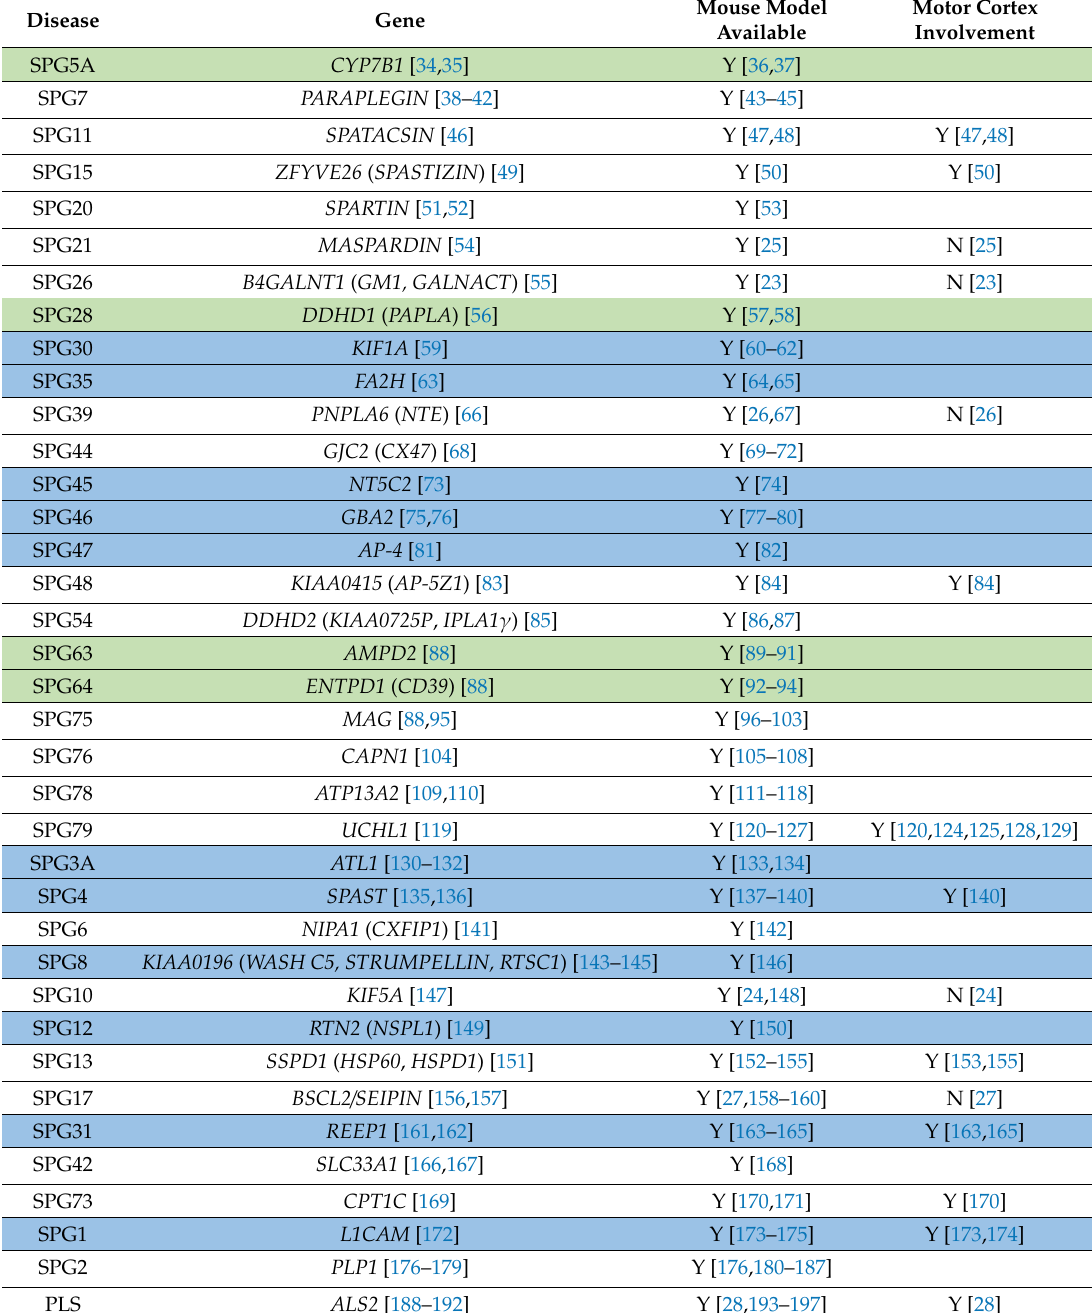
Mouse Model Motor Cortex Available Involvement